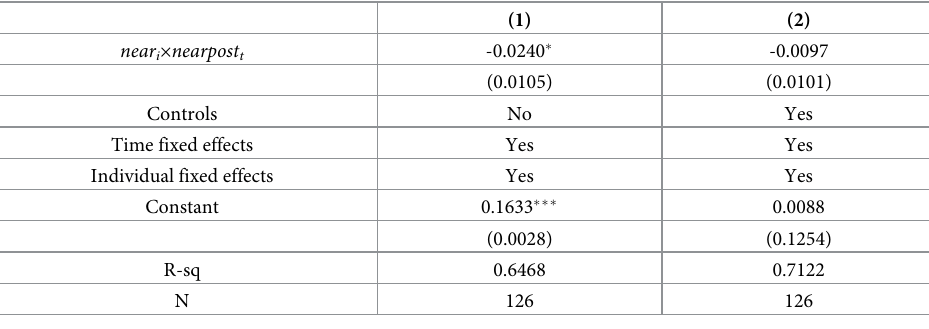
Table 10. The radiation effect or siphon effect of